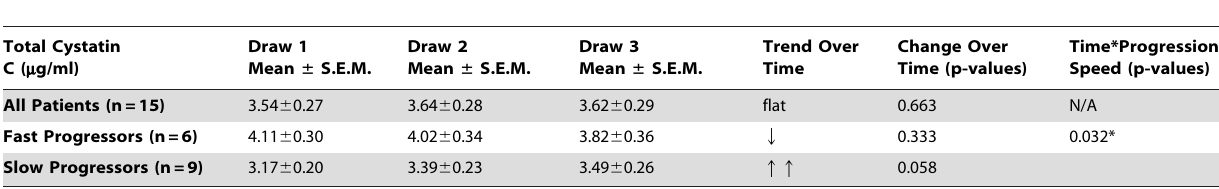
Total Cystatin C ( m g/ml)